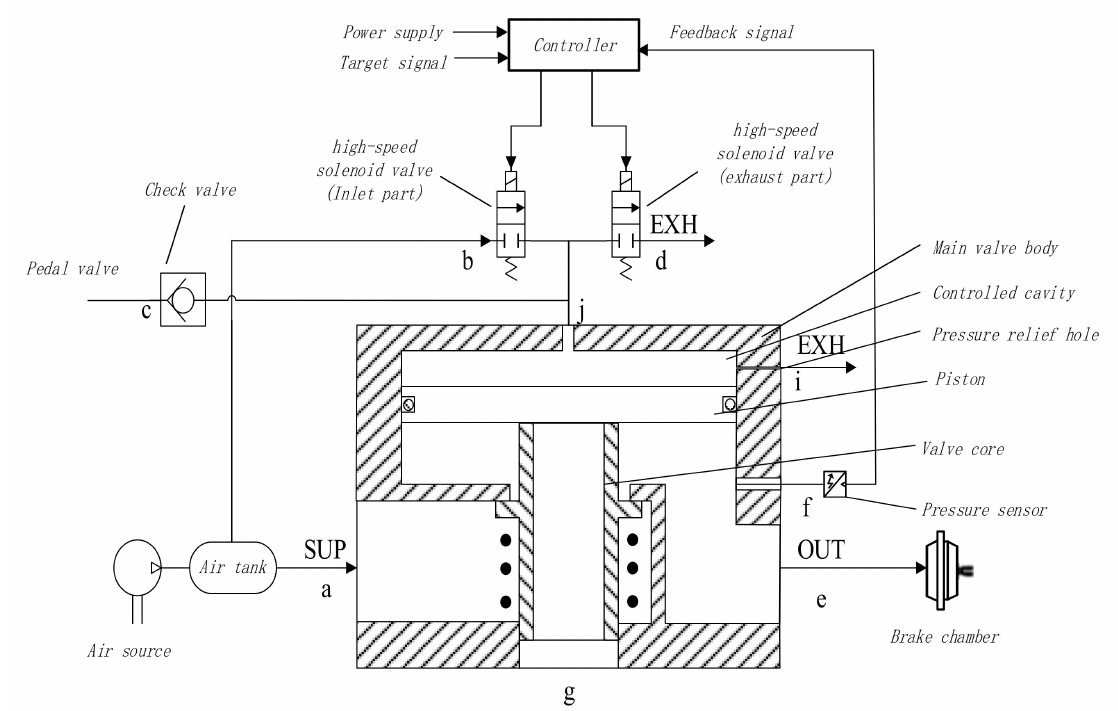
Figure 1. Principle drawing of an automatic pressure regulating valve. (a) inlet port; (b) high-speed inlet port; (c) inlet port (pedal valve); (d) high-speed exhaust port; (e) outlet port; (f) pressure sensor interface; (g) exhaust port; (i) pressure relief hole; (j) controlled cavity inlet